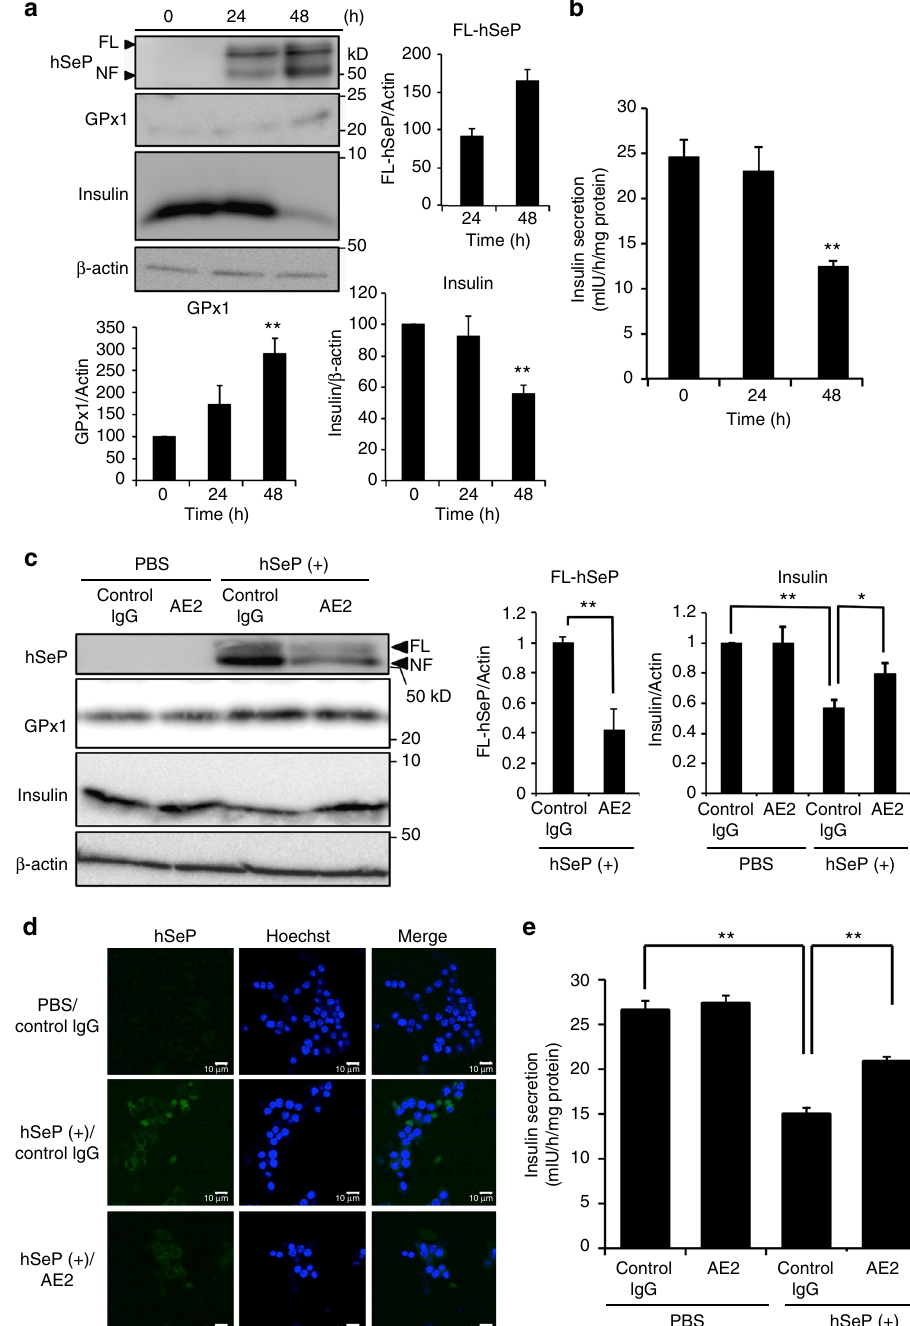
Fig. 5 The SeP-neutralizing Ab improved insulin secretion by MIN6 cells. a Insulin levels of MIN6 cells were signi fi cantly decreased by excess human SeP. MIN6 cells were incubated with 10 µ g/mL hSeP for the indicated time, and then whole-cell lysates were analysed by western blotting with anti-hSeP Ab BD1, anti-GPx1 Ab, and anti-insulin Ab ( n = 3, means ± s.d.). The band intensity of hSeP was only evaluated in hSeP-treated cells for 24 and 48 h. ** P < 0.01, vs. time 0, Tukey-ANOVA. b Insulin secretion by MIN6 cells was signi fi cantly decreased by excess human SeP. MIN6 cells were incubated with 10 µ g/mL hSeP for the indicated time, and then insulin secretion induced by high glucose levels was evaluated ( n = 3, means ± s.d.). ** P < 0.01, vs. time 0, Tukey-ANOVA. c – e Insulin secretion of MIN6 cells was signi fi cantly improved by AE2. MIN6 cells were incubated with 10 µ g/mL hSeP in the presence of AE2 and control IgG (500 µ g/mL) for 48 h, and then whole-cell lysates were analysed by western blotting ( c , n = 3, means ± s.d.). The band intensity of hSeP was only evaluated in hSeP-treated cells (** P < 0.01, Student's t -test). * P < 0.05, ** P < 0.01, Tukey-ANOVA. MIN6 cells treated with hSeP and AE2 for 48 h were examined immunohistochemically using anti-hSeP Ab ( d ) or evaluation of insulin secretion induced by high glucose levels ( e , n = 3, means ± s.d.). Scale bars = 10 µ m. * P < 0.05, ** P < 0.01,